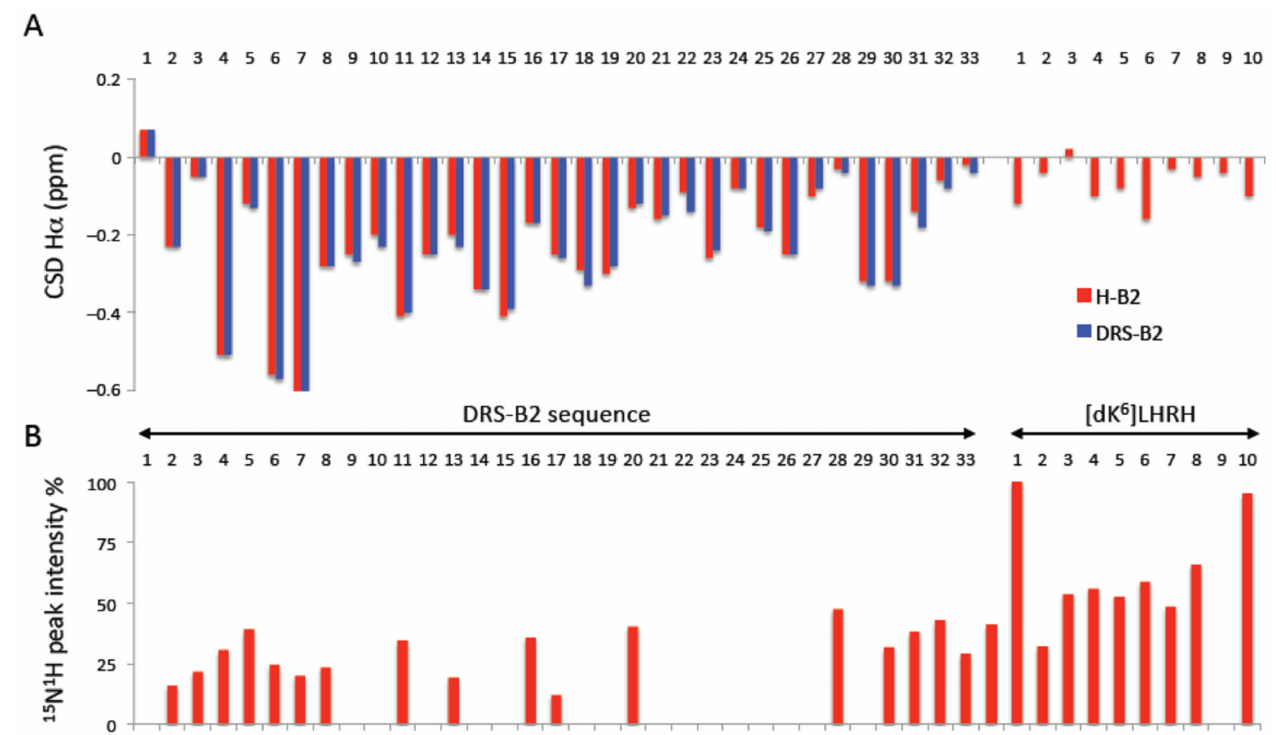
Figure 7. Structure of H-B2 and DRS-B2 analyzed by NMR. ( A ) Chemical shift deviations (CSDs) of H α protons of DRS-B2 and H-B2 in the presence of DPC. The CSD values were calculated as the difference between observed chemical shifts and random coil chemical shifts. ( B ) Intensity of 15 N- 1 H peaks on 2D 15 N- 1 H HSQC. The intensities were normalized to the highest intensity peak. Only well resolved, unambiguously assigned peaks were